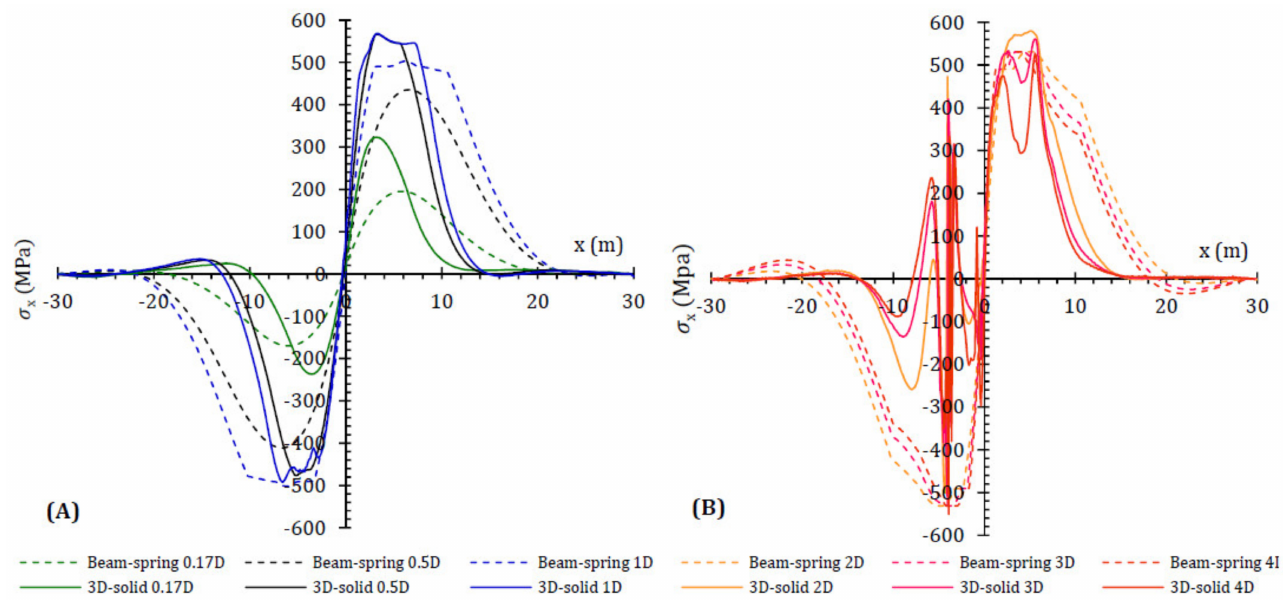
Figure 16. Maximum/minimum longitudinal stresses of a buried pipeline subjected to a 60 ◦ strike-slip fault, 3D solid model versus beam–spring model. ( A ) Cases with a 0.17D to 1D fault movement; ( B ) cases with a 1D to 4D fault movement.